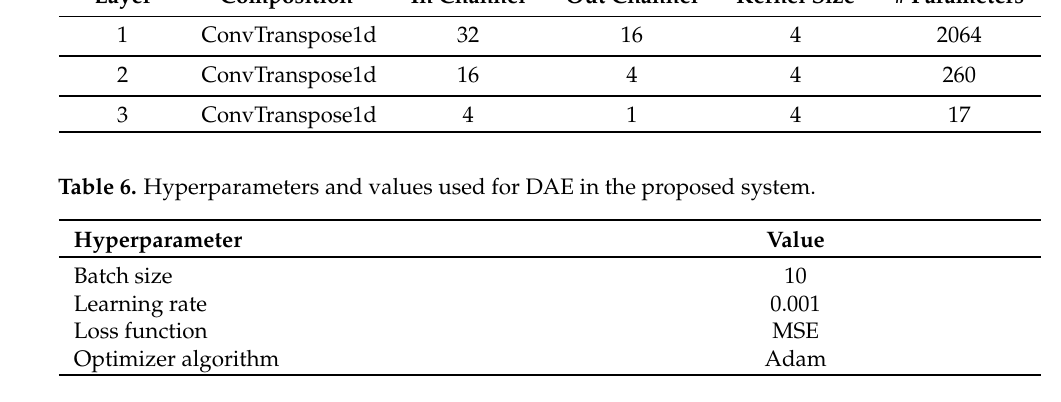
Table 5. Network layer structure of the decoder in DAE used for the proposed system. Layer